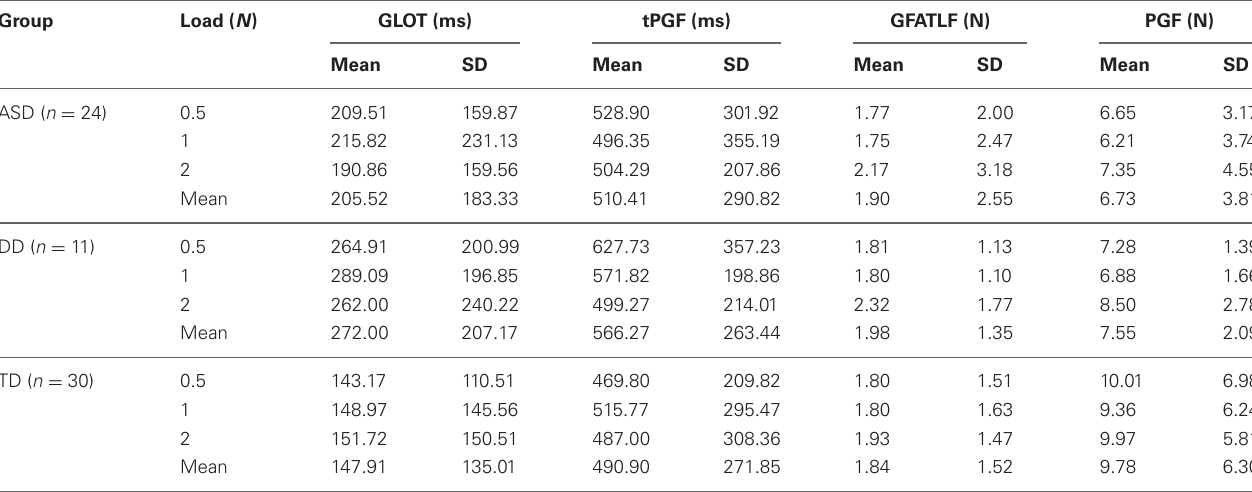
Table 2 | Motor coordination variables across participants. Group